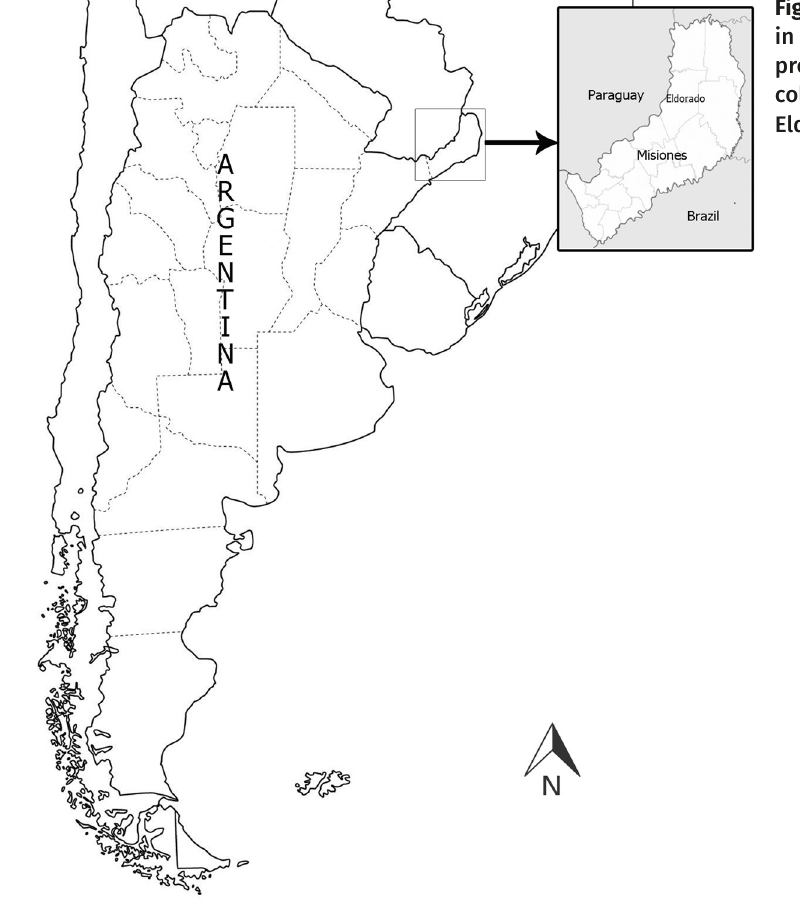
Figure 1. Location